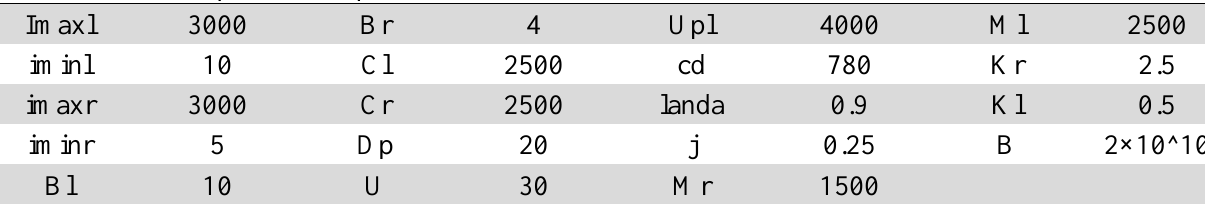
parameters of examples with 3 periods(T=3)